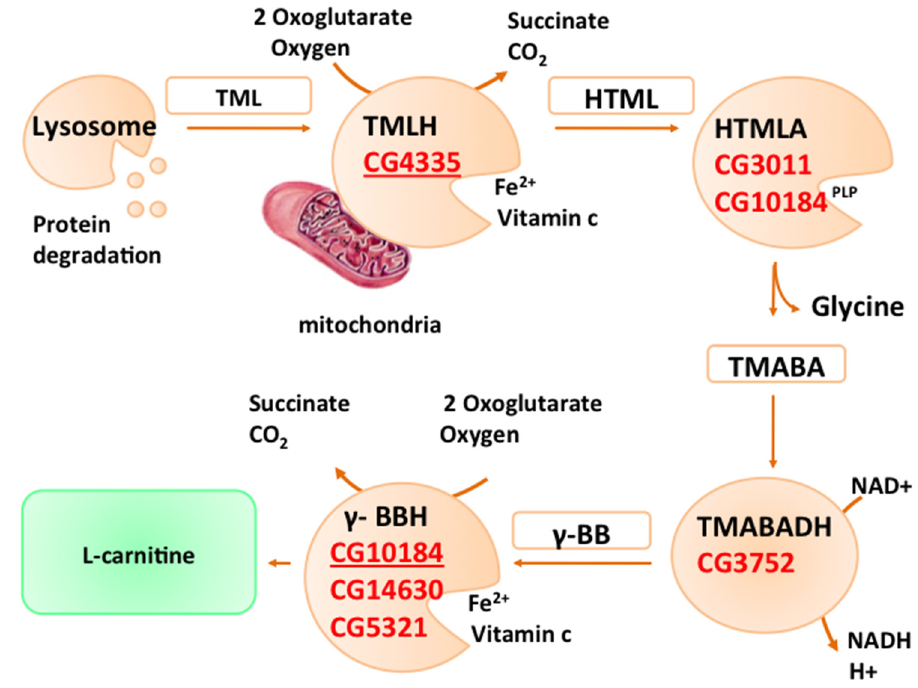
Figure 1. L-Carnitine biosynthesis pathway. Drosophila orthologs are reported near each counterpart with the FlyBase CG number(s) in red. The CG numbers with the best hit(s) are underlined.